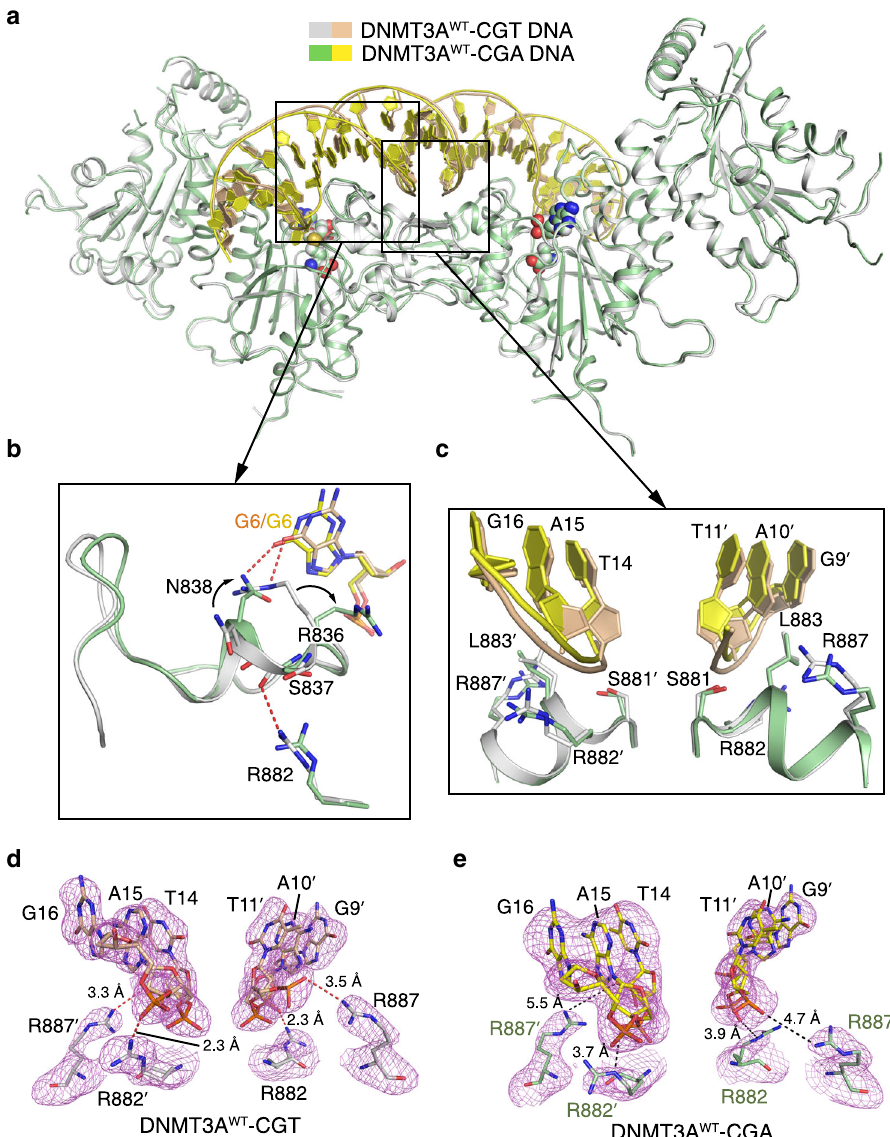
Fig. 2 Structural comparison of the DNMT3A WT – CGA and DNMT3A WT – CGT complexes. a Structural superposition of the DNMT3A WT – CGA and DNMT3A WT – CGT (PDB 5YX2) complexes. b Structural comparison of the TRD loop and its interactions with CpG guanine (G6) and R882 in the DNMT3A WT – CGA and DNMT3A WT – CGT complexes. The conformational rearrangements of the TRD residues between the two complexes are indicated by arrows. c Structural comparison of the RD interface between the DNMT3A WT – CGA and DNMT3A WT – CGT complexes. d,e Close-up views of the R882- and R887-engaged DNA interactions in the DNMT3A WT – CGT (PDB 5YX2) ( d ) and DNMT3A WT – CGA ( e ) complexes, with the Fo – Fc omit map (violet) contoured at 2.0 sigma level. The distances for hydrogen-bonding and electrostatic interactions are measured and indicated by dashed lines, colored in red and black,